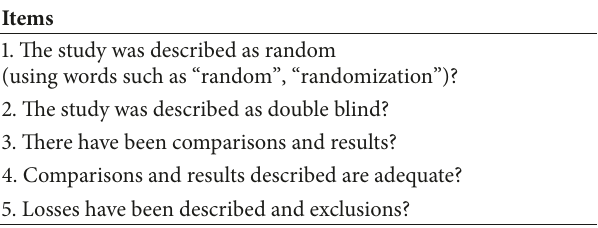
Table 1: Scale of assessment of the quality of clinical studies.